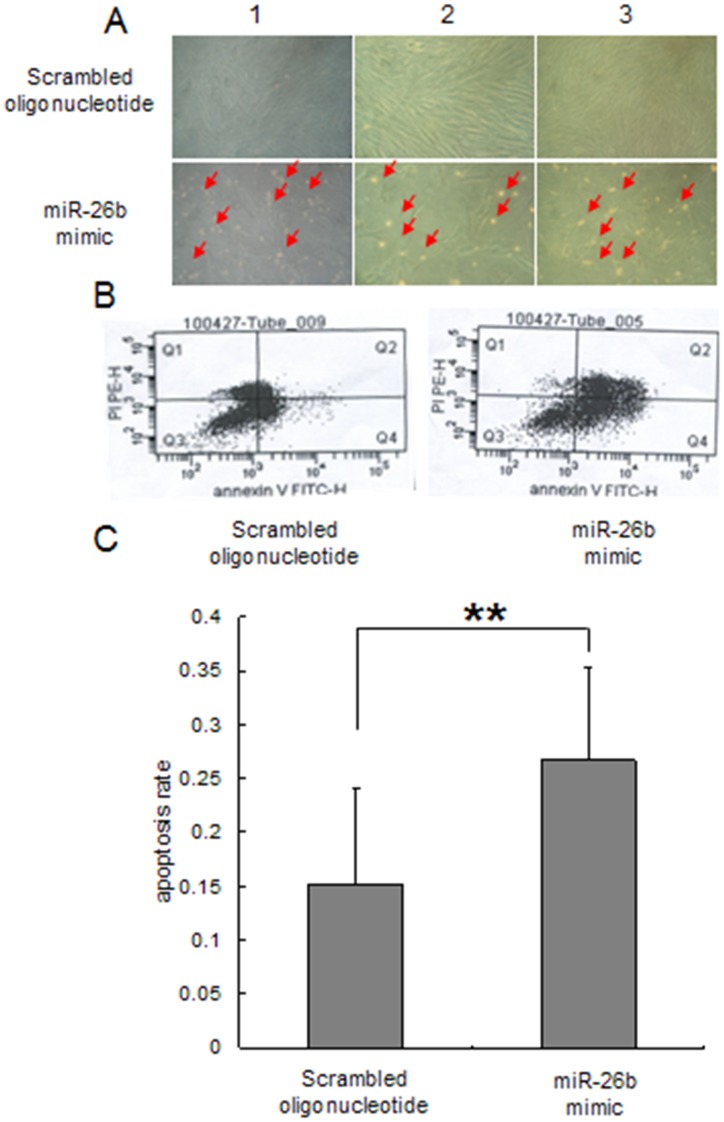
The effect of miR-26b on granulosa cell apoptosis in vitro.A, Porcine granulosa cells undergo apoptosis after miR-26b mimic treatment (three replicates). Granulosa cells were transfected with the miR-26b mimic or scrambled oligonucleotide (150 nM) after an additional 72-h culture (red arrow shows apoptosis cells). B and C, flow cytometry analysis (FACS) of apoptosis. After treatment and additional culture, cells were harvested and stained with Anti-annexin V-propidium iodide followed by FACS analysis. Apoptosis improved significantly following the miR-26b transfection.